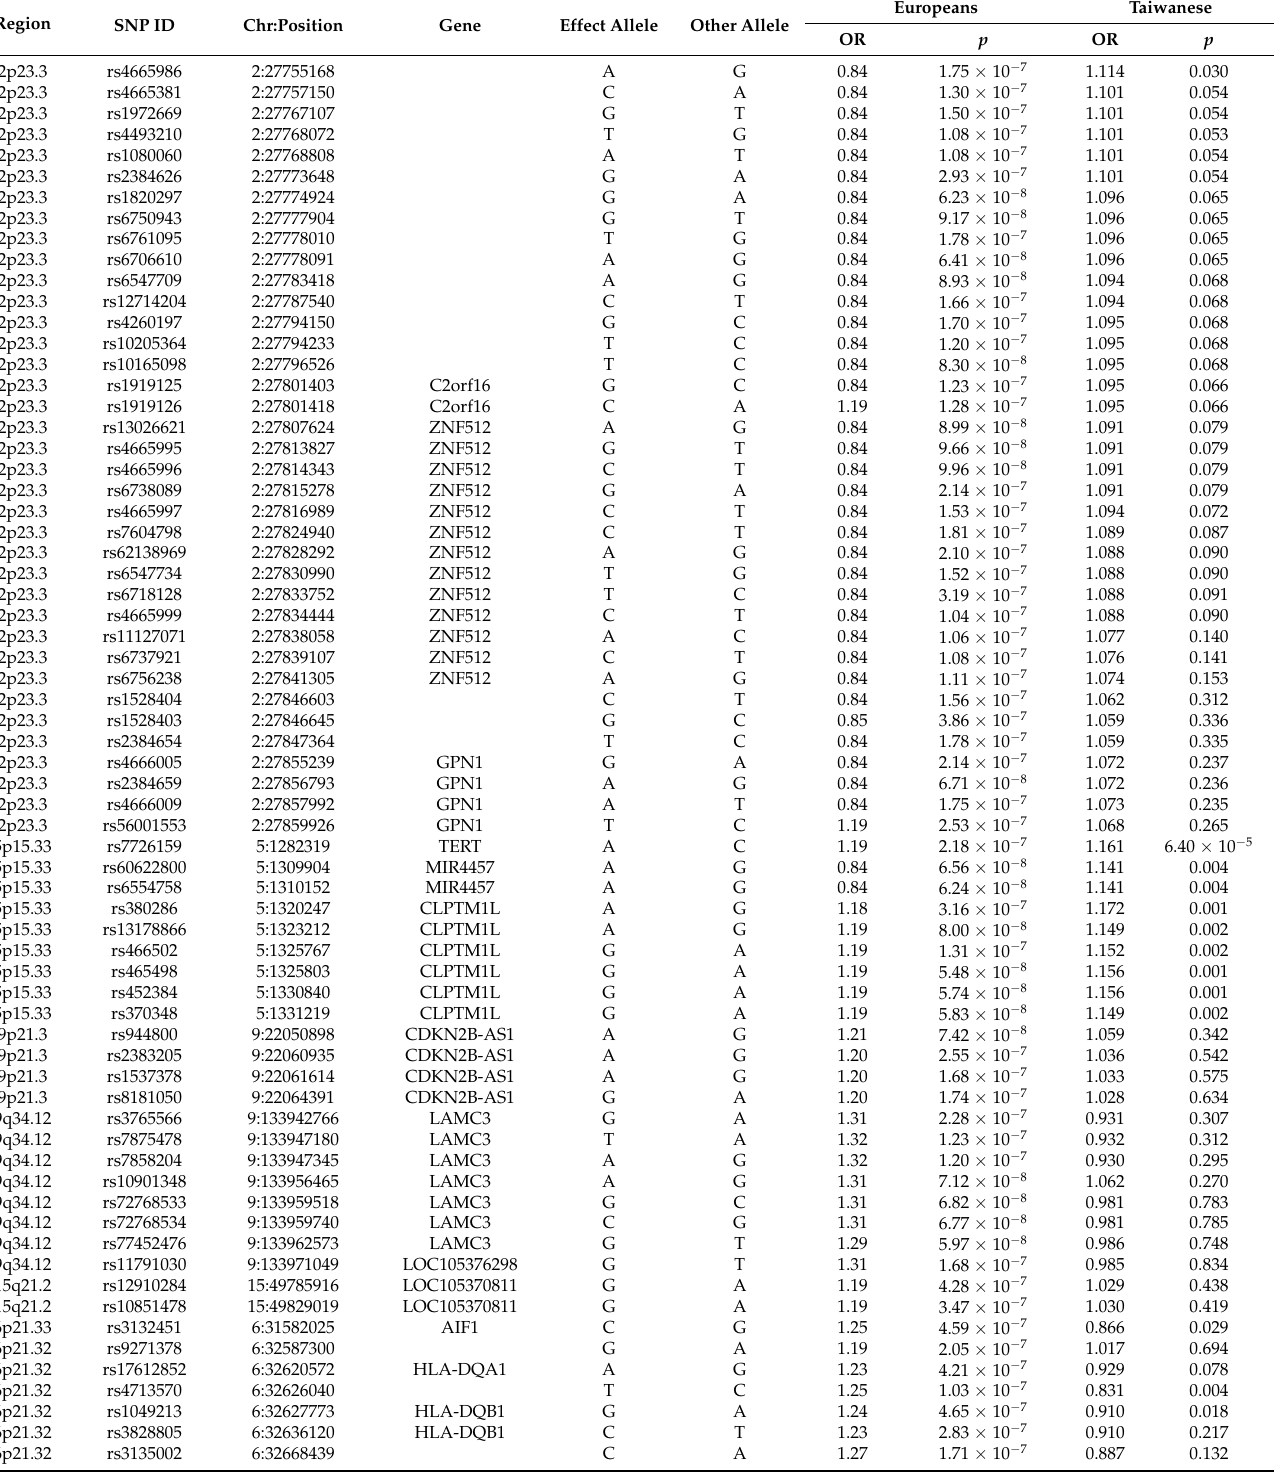
Table 4. Borderline significant SNPs (5 × 10 − 8 < p < 1 × 10 − 7 ) in Europeans and their associations with oral cancer in